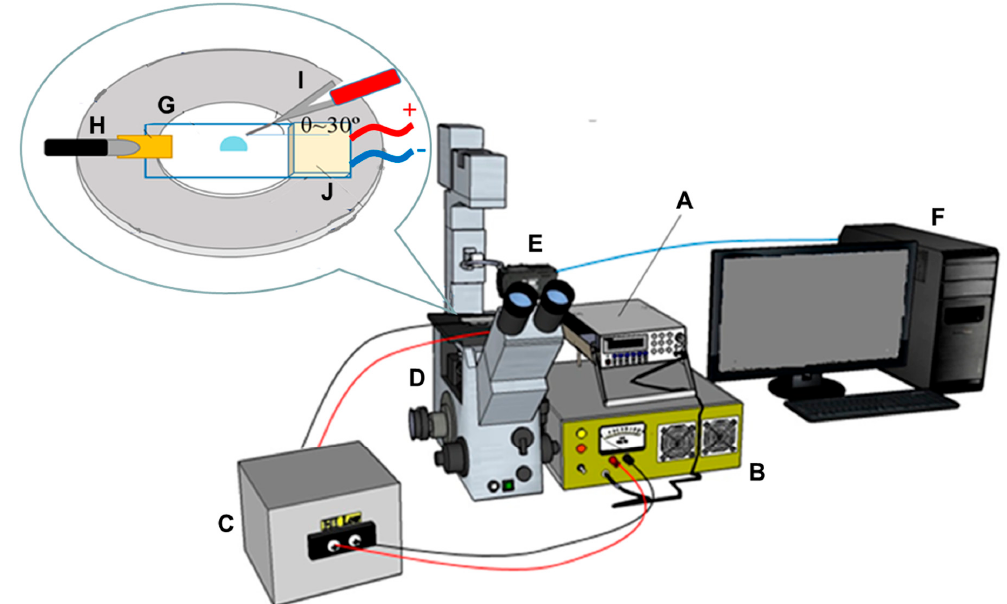
Figure 1. The schematic illustration of experimental set-up for the evaporation and concentration of bacteria sample using ionic wind-induced centrifugal flows enhanced with thermoelectric drying. ( A ) functional generator; ( B ) power amplifier; ( C ) transformer; ( D ) inverted-view microscope; ( E ) CCD camera; ( F ) personal computer. The top embedded graph shows the zoom-in graph of evaporation and concentration device, ( G ) containing a sessile sample droplet on a glass slide. One piece of copper ribbon electrode ( H ) is attached on one end of the slide. One corona needle ( I ) inclined at the angle 30 ◦ is hanging above the reservoir. One thermoelectric heating chip ( J ) is adhered on the other end of slide. The device is stationed on the microscope stage as pointed by the zoom-in